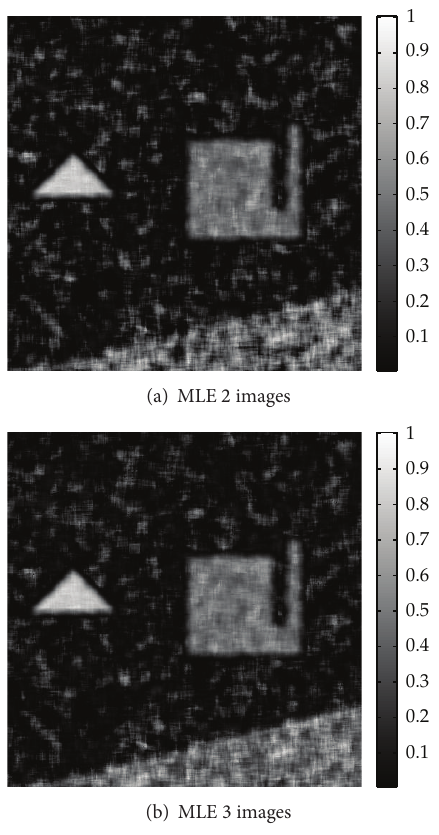
Figure 6: Estimates of 𝑃 2 using 2 or 3 low flux intensity images for the synthetic polarimetric images for an estimation window of size 𝑛 = 15 × 15 . MLE: maximum likelihood estimator.